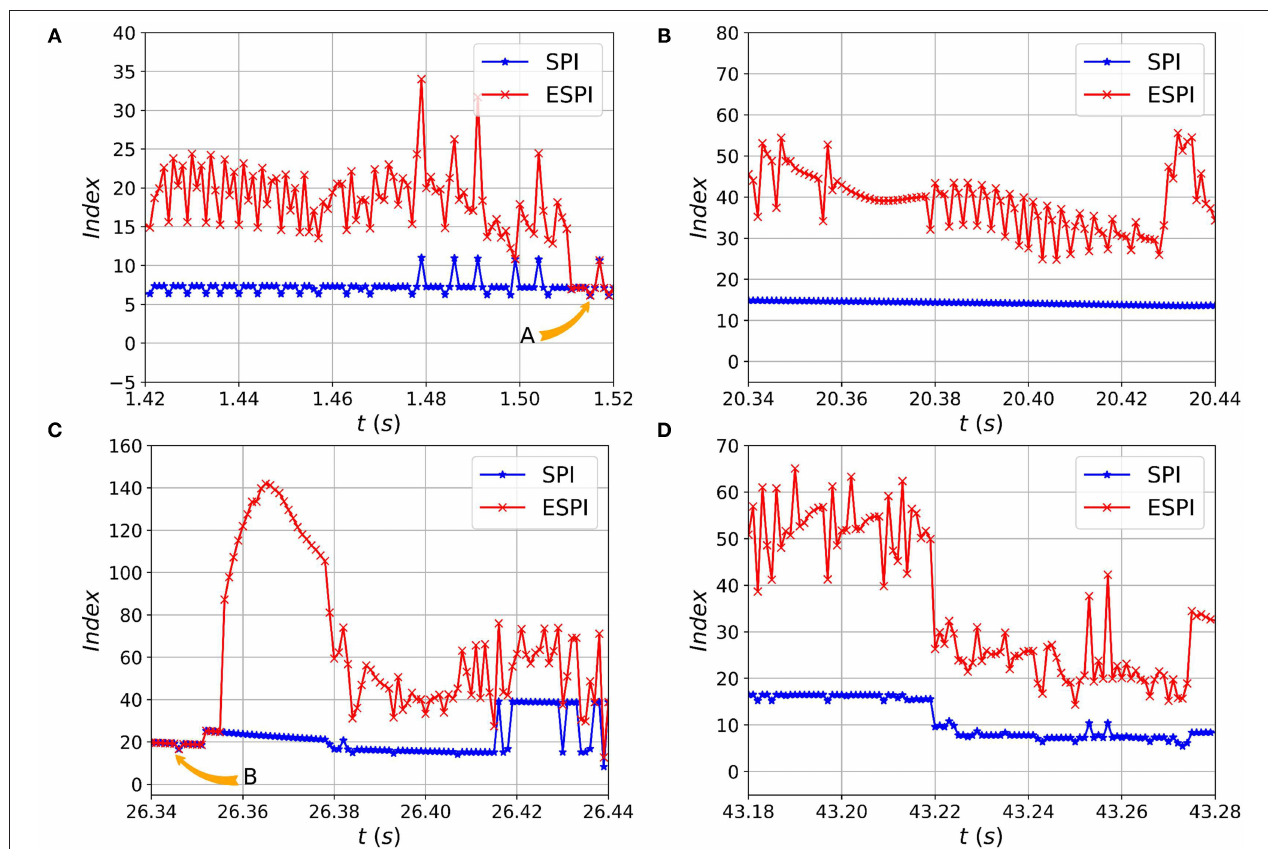
FIGURE 8 | The comparison of ESPI and Stability Pyramid Index (SPI) during the walking experiments. The red and blue lines and dots represent ESPI and SPI obtained from the preliminary analysis at different times. The system is safe when SPI is less than 40, while ESPI is less than 150. The data in (A–D) shows that the ESPI is more sensitive than SPI, and they are the same when the CoM’s velocity is zero labelled A and B in (A,C) respectively.